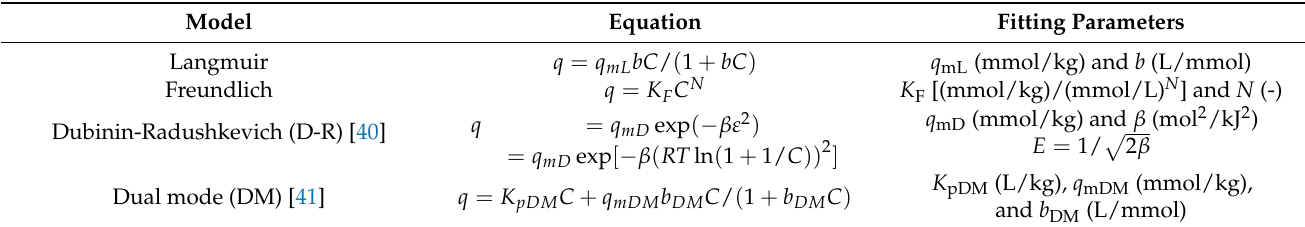
Table 3. Adsorption isotherm models used in this study.